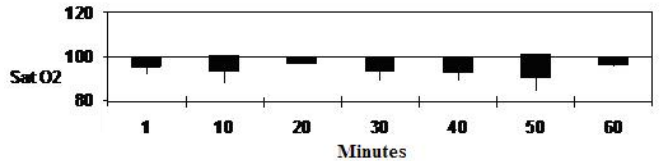
FIGURE 4 - Oxygen Saturation during transoperatory